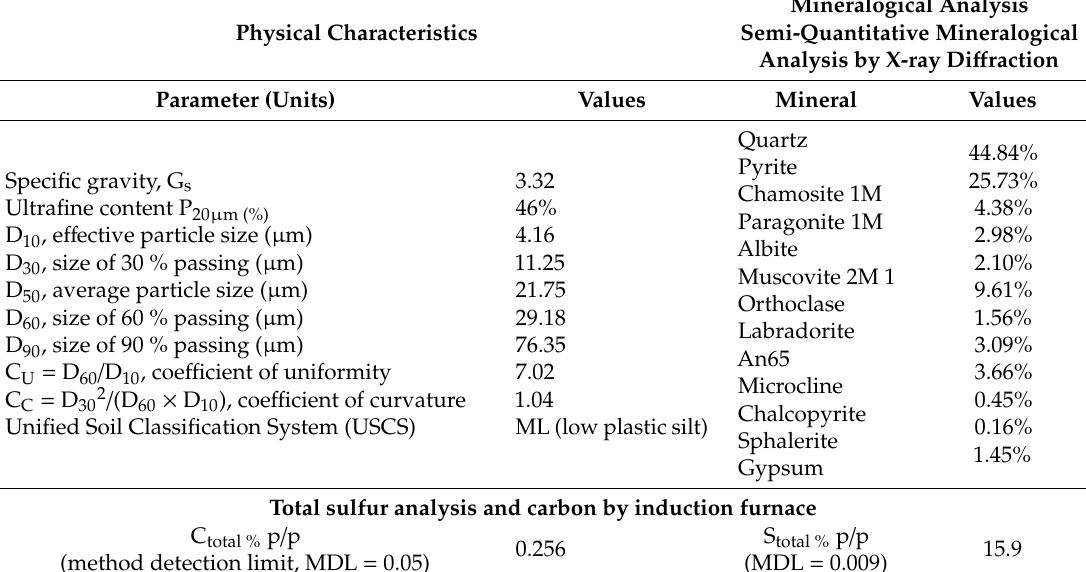
Table 2. Characteristics of the mine tailings used in the experimental tests (LaRonde mine